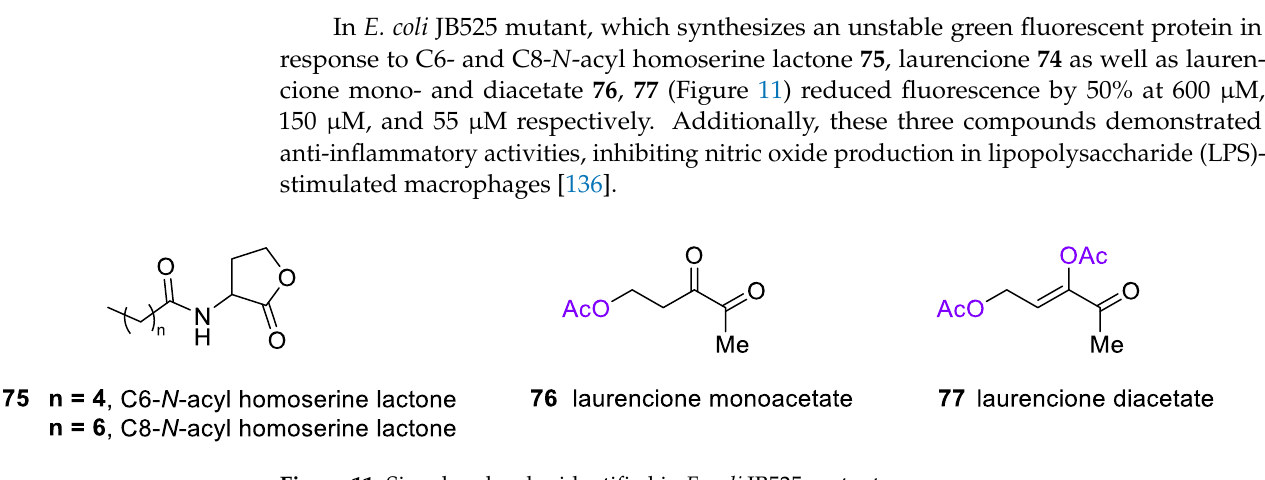
Figure 11. Signal molecules identified in E . coli JB525 mutant.